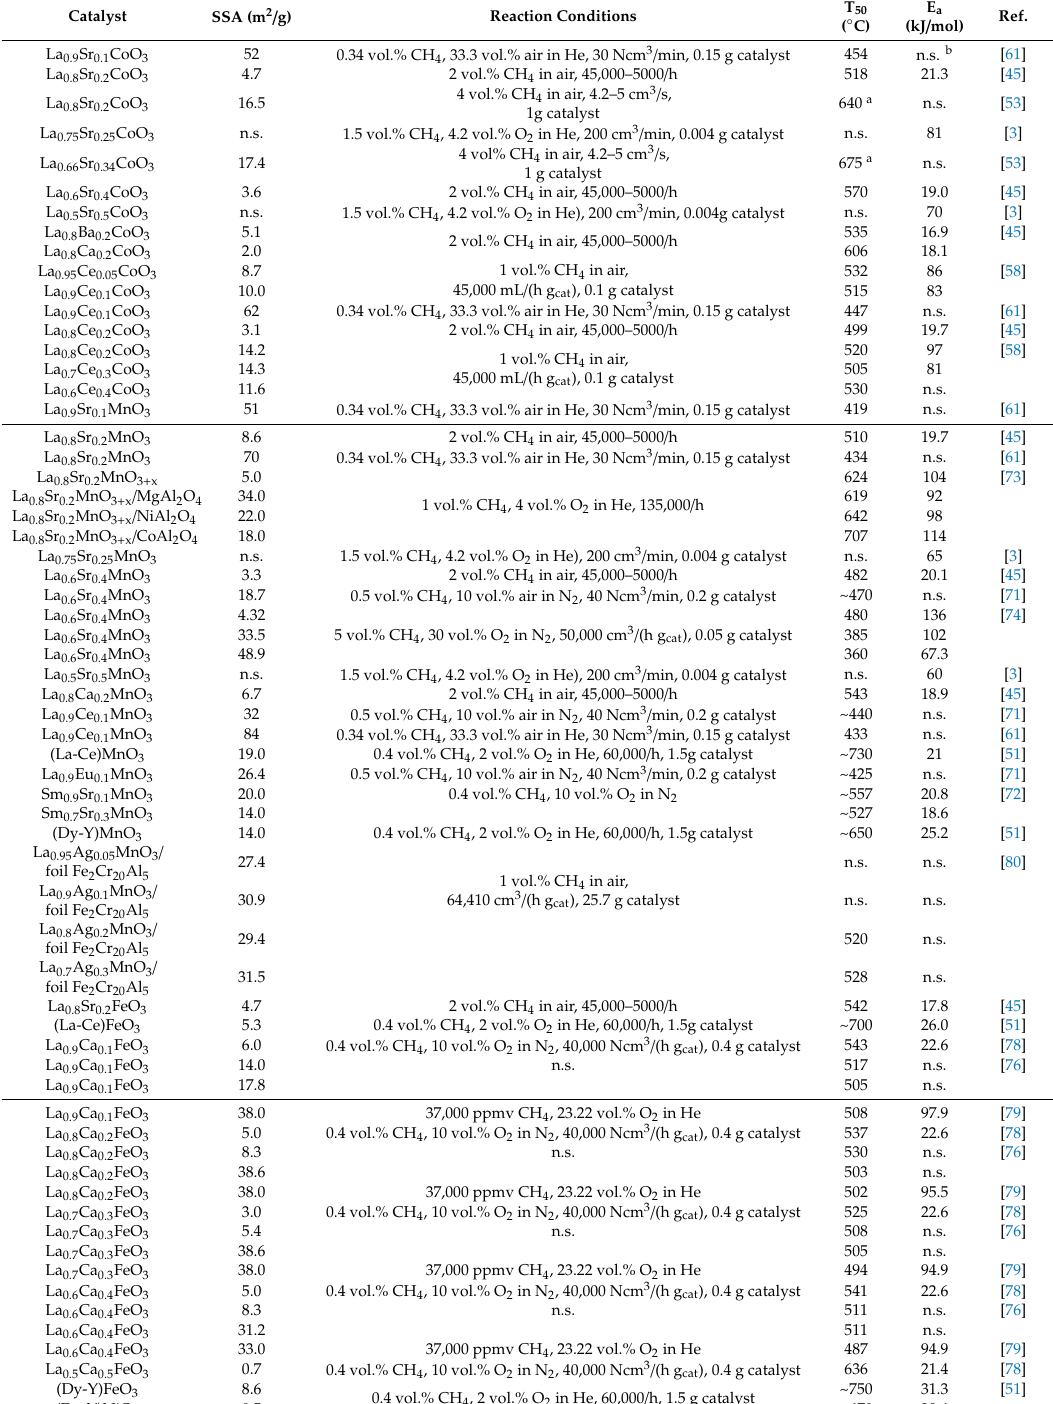
Table 10. Performances of A-site-doped perovskite-type materials for the catalytic combustion of methane.